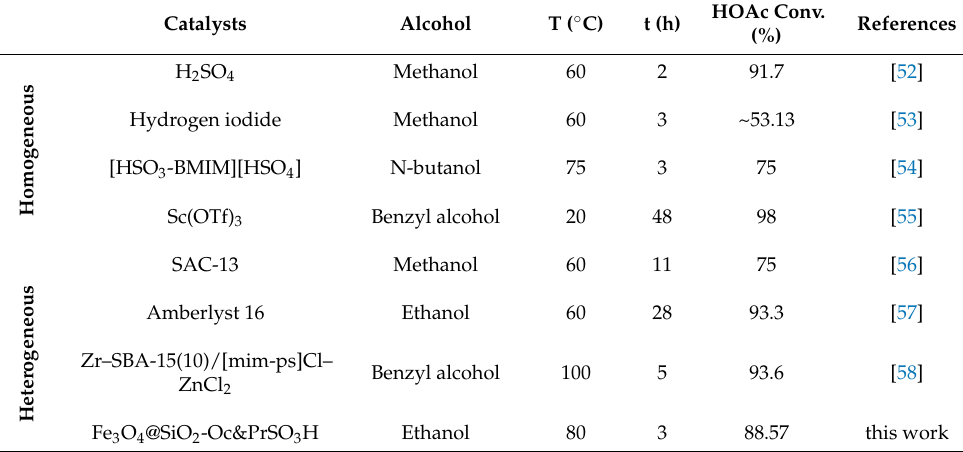
Table 4. Catalytic evaluation of different catalysts for esterification of HOAc and